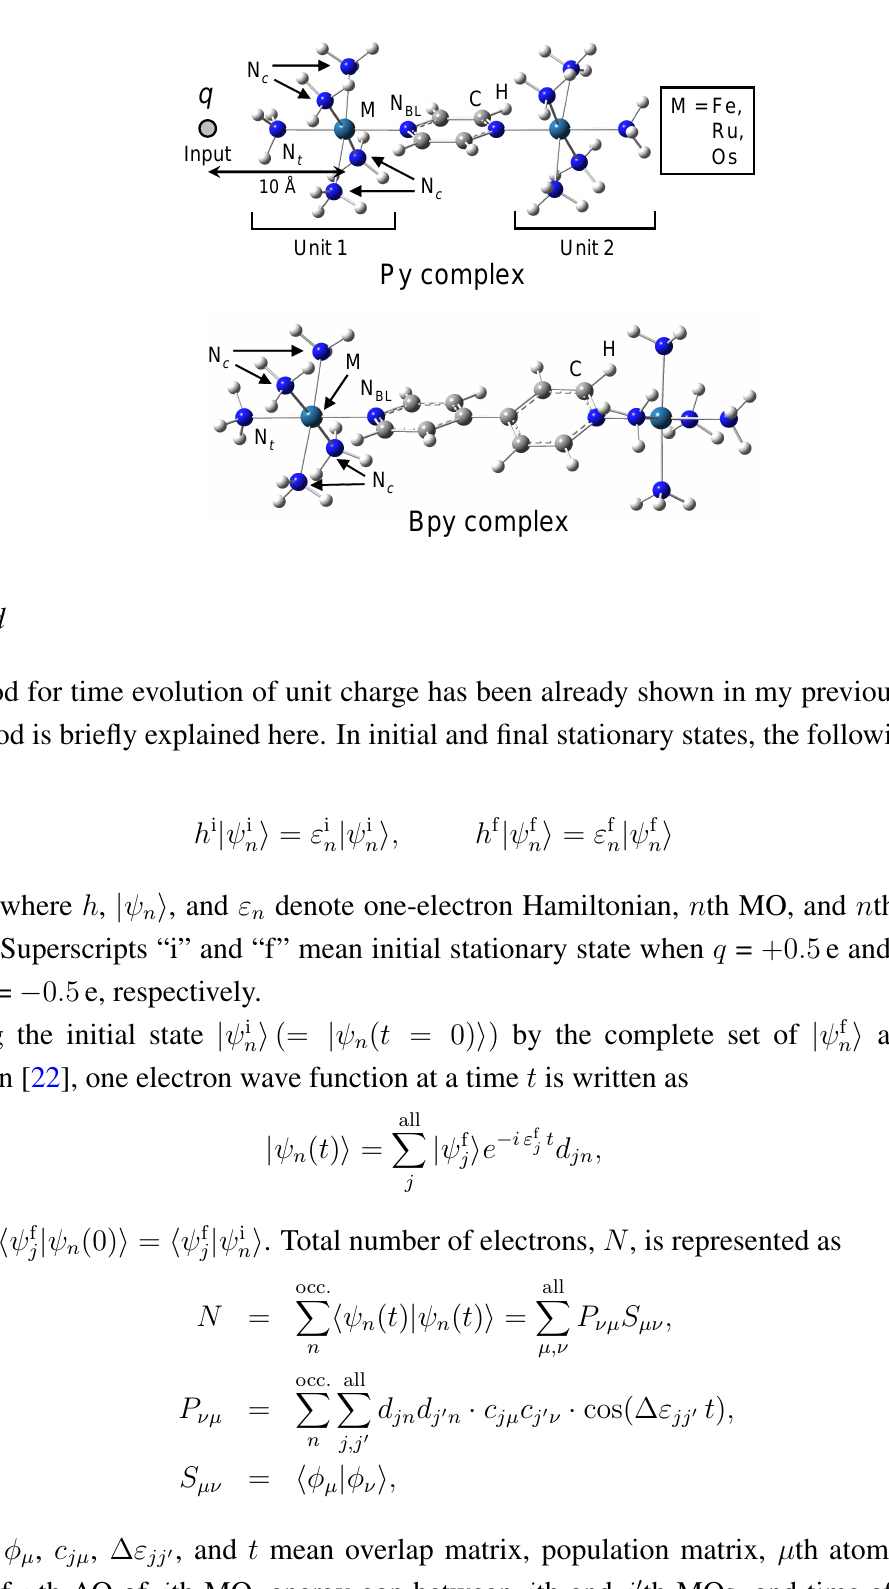
Figure 3. Schematic structures of py and bpy complexes. Input q is placed at a distance r = 10 q − M